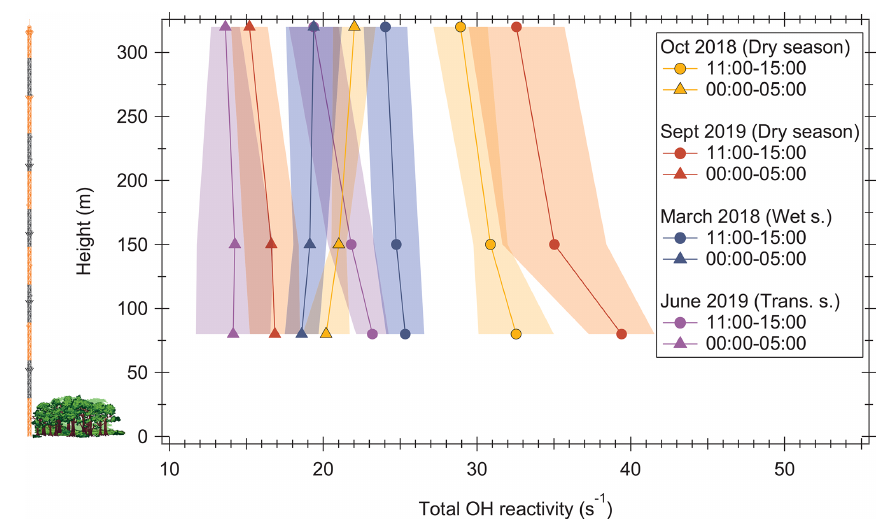
Figure 1. Profiles of total OH reactivity at the ATTO tall tower for two dry seasons, one wet season, and one transition season. Values are averages of several days of measurement (5–13d; see Sect. 2.2). The shaded areas represent the standard deviation of the data. The left part of the figure illustrates the tower and the canopy height at the same scale as the OH reactivity profiles. Wet s. is wet season; Trans. s. is transition season. All times are local